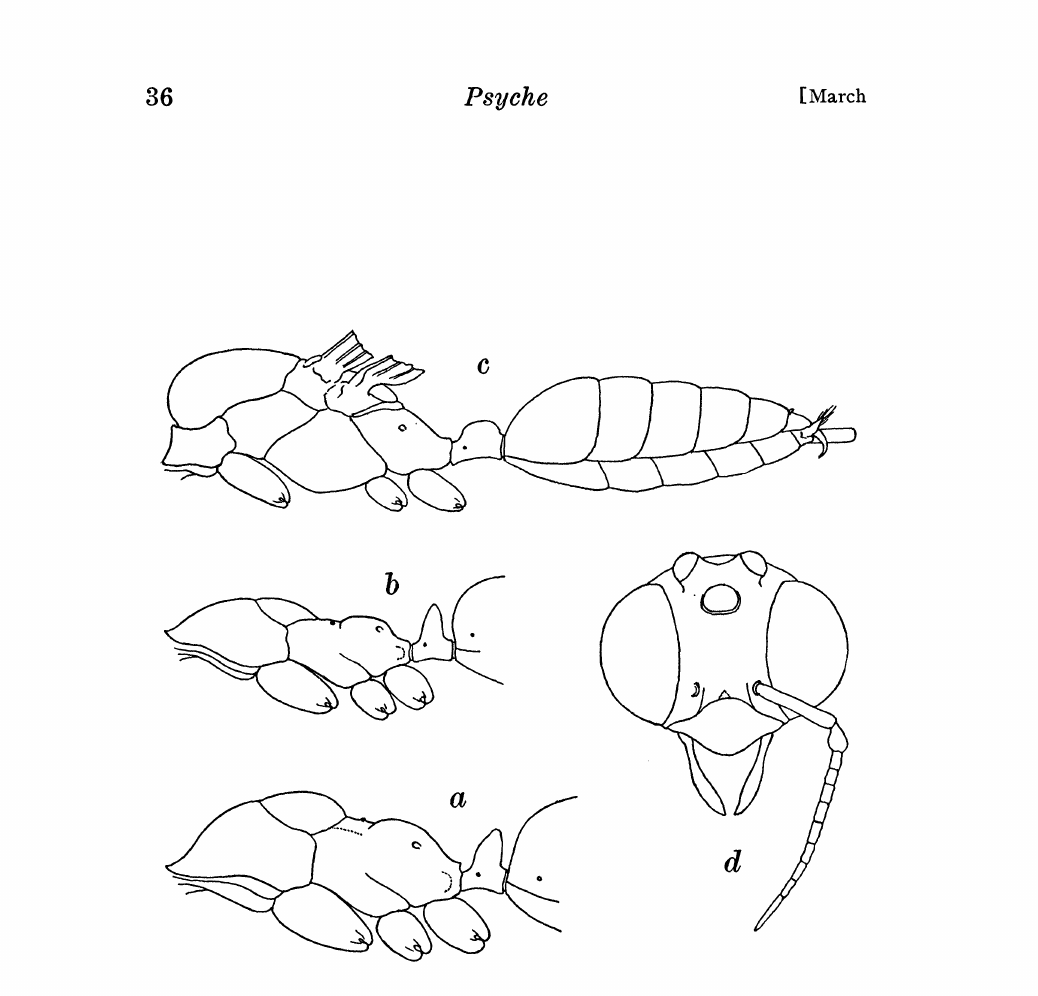
Fig. 1. Gesomyrmex luzonensis Wheeler, var. chapmani, var. nov. a, thorax and petiole of worker maxima in profile; b, same of worker minima; c, thorax and abdomen of male; d, head of male, dorsal